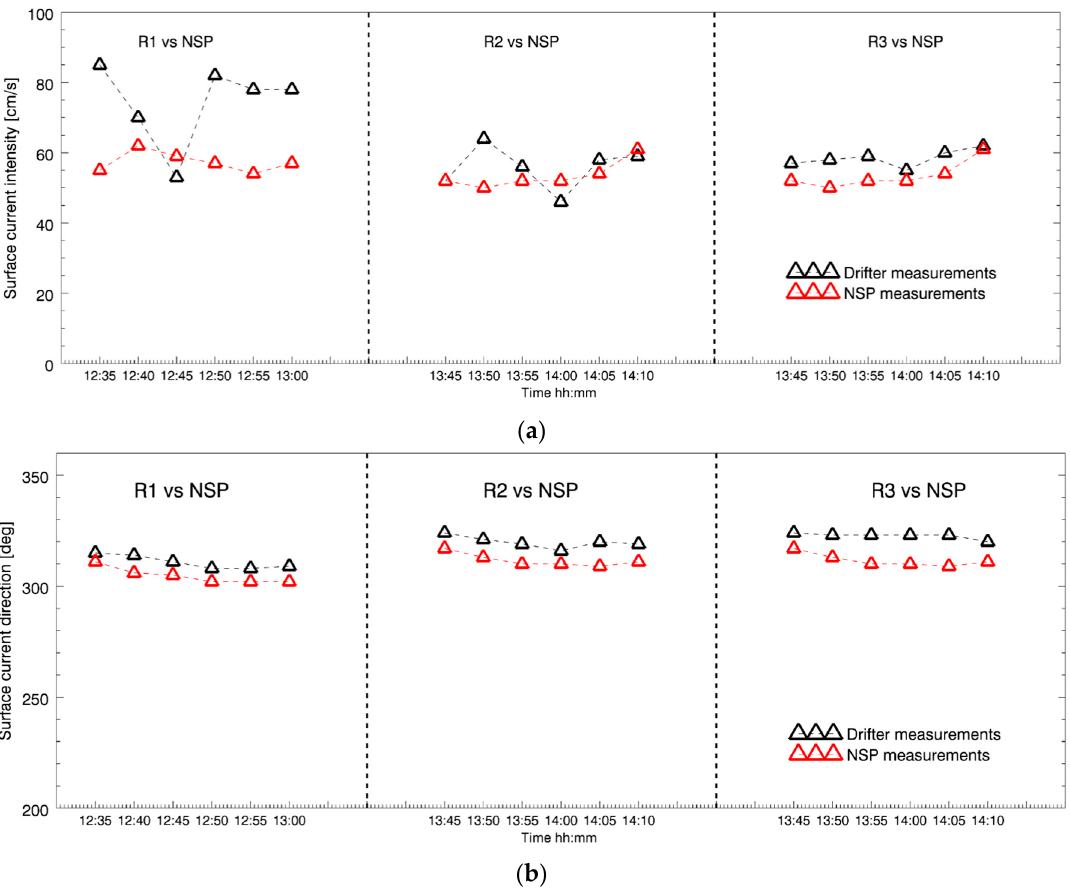
Figure 5. Comparison between the measurements of surface current by means wave radar (red triangle) and drifters (black triangle). ( a ) Comparison of the surface current intensity; ( b ) Comparison between surface current directions.